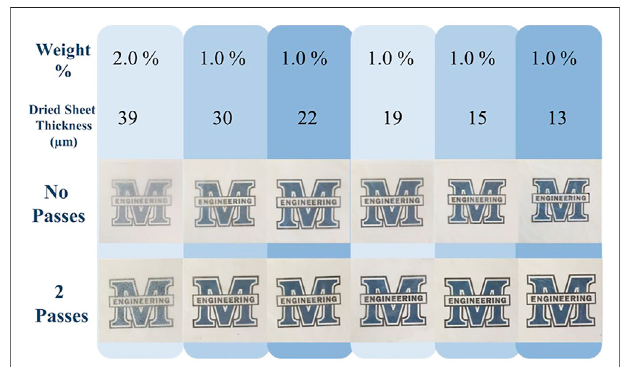
FIGURE 8 | CNF Sheet Transparency. The effect of varying sheet thickness and calendaring on transparency.